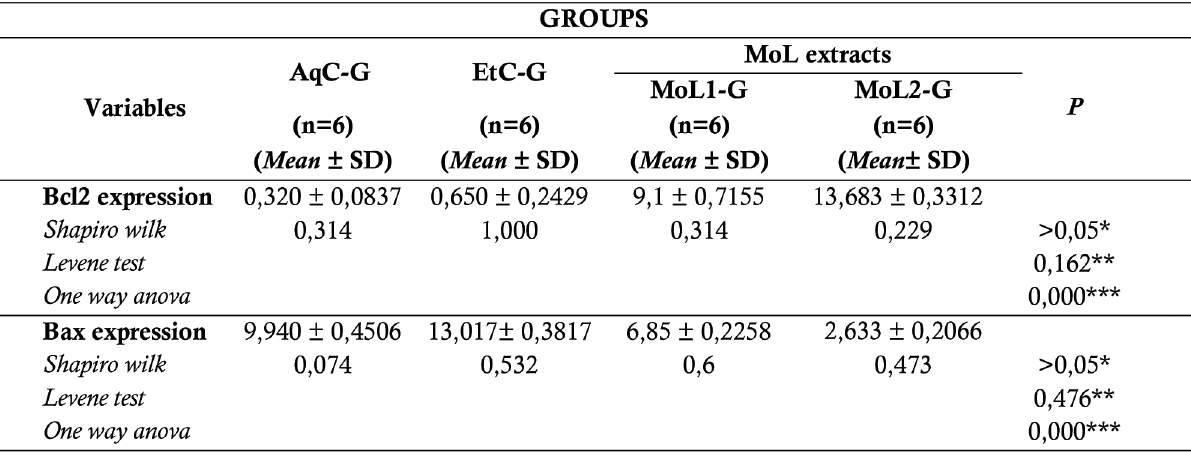
Figure2. Bax expression counts in the renal tubulus of control group and the experimental group, IHC staining, using the Olympus BX Light Microscope at 41 times magnification showed a positive immunostaining expression against Bax. Analysis of Bcl-2 and Bax Expression on different dose of Moringa Leaf